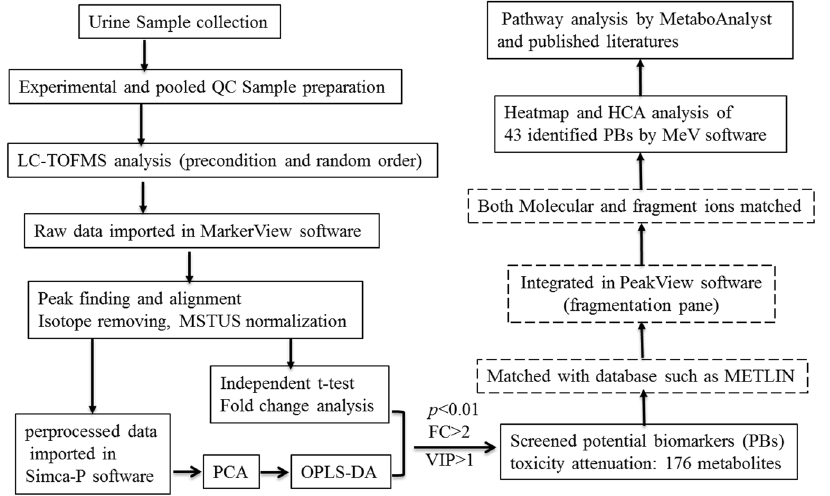
Figure 1. LC-TOF/MS based roadmap for the urinary metabolomics study on toxicity-attenuation effect of HuangQi Injections in CDDP-exposed